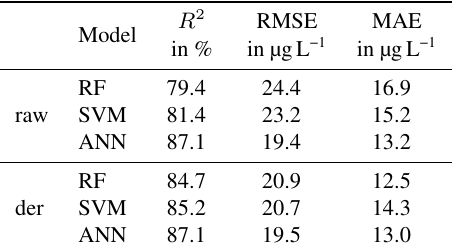
Table 6. Regression results for chlorophyll a estimation with 20nm spectral resolution for the raw dataset (raw) and the dataset with derivatives